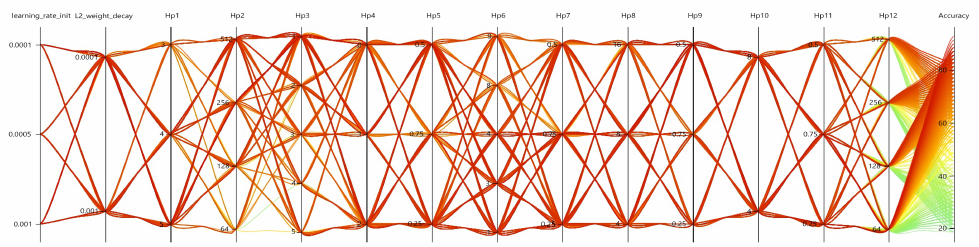
Figure 19. Hyperparameter